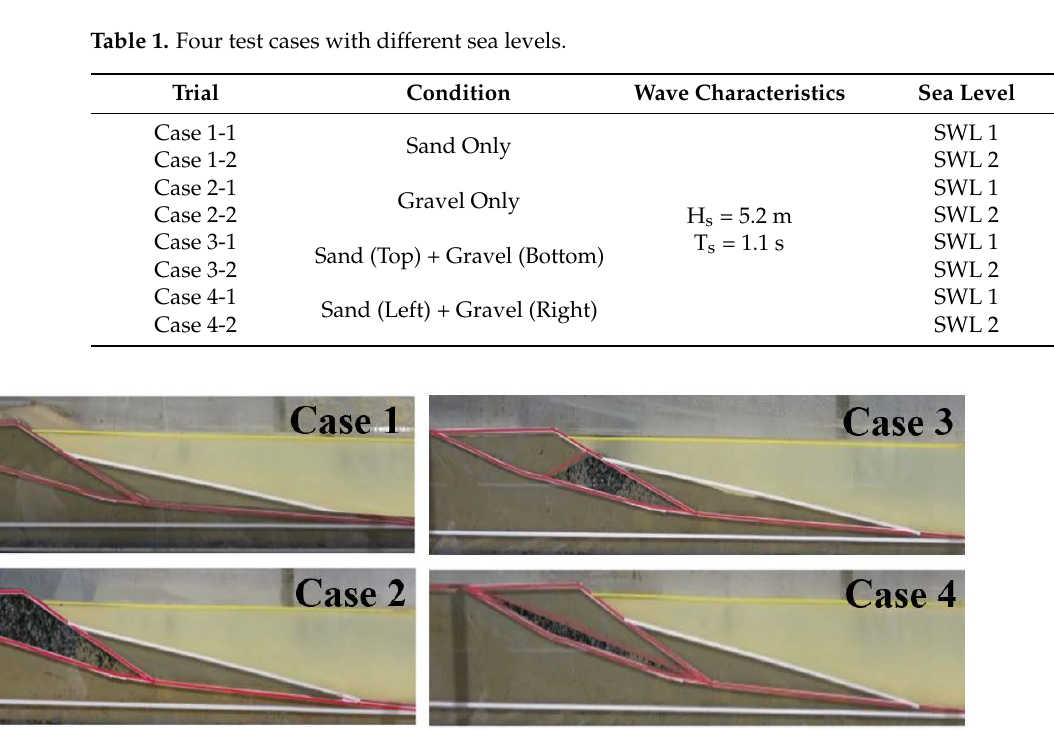
Figure 4. Four test cases with two SWLs tested with 120 min runs each.